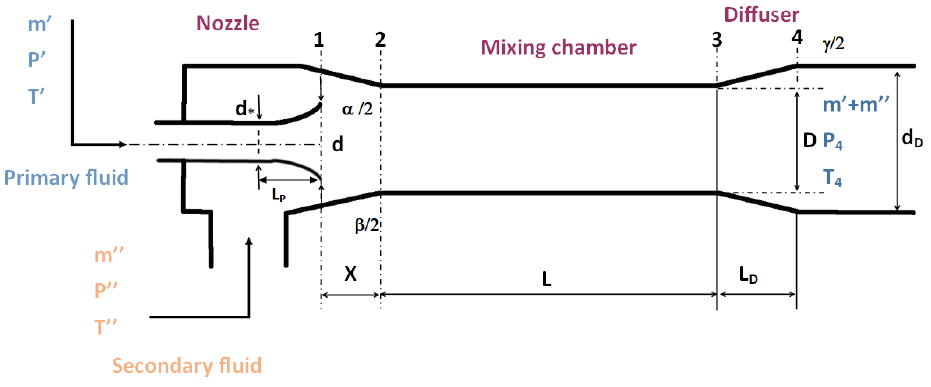
Figure 3. Schematic of the ejector.